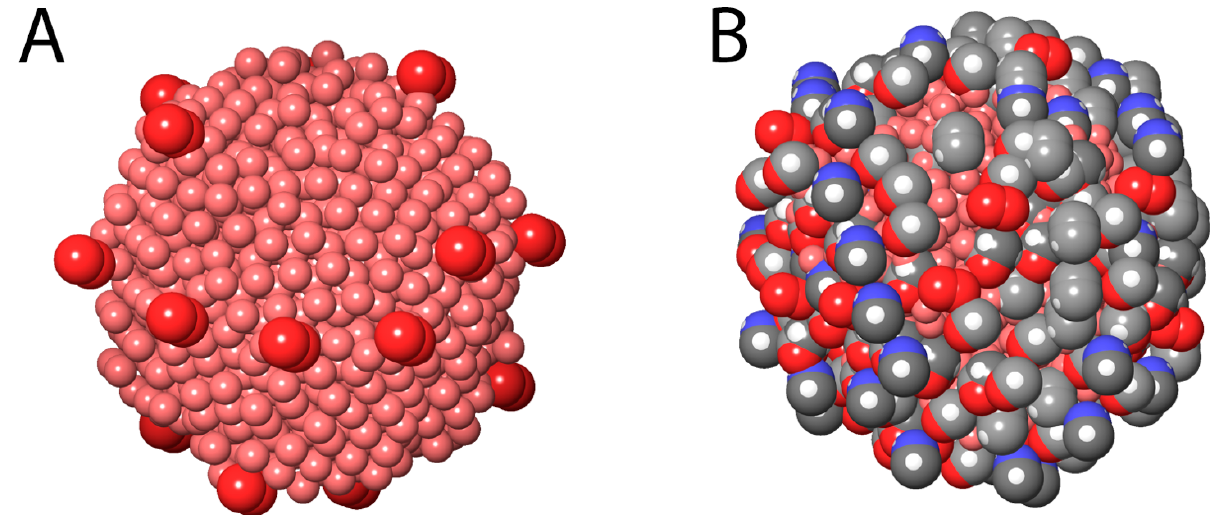
Figure A1. Schematic illustration of the models of aloe vera-mediated tellurium nanoparticles (AV-TeNPs) without a biomolecule-based external layer/coating ( A , represented with pink and some red spheres) and with a biomolecule-based external layer/coating ( B , represented by gray, red, blue, and white spheres) obtained from the simulations. The nanoparticles are shown as a space-filling model (CPK model). Tellurium (Te) is in pink, carbon (C) in gray, oxygen (O) in red, nitrogen (N) in blue, and hydrogen (H) in white. Both dark and light gray represent carbon atoms, and the color difference is because of the light source of the simulation software.